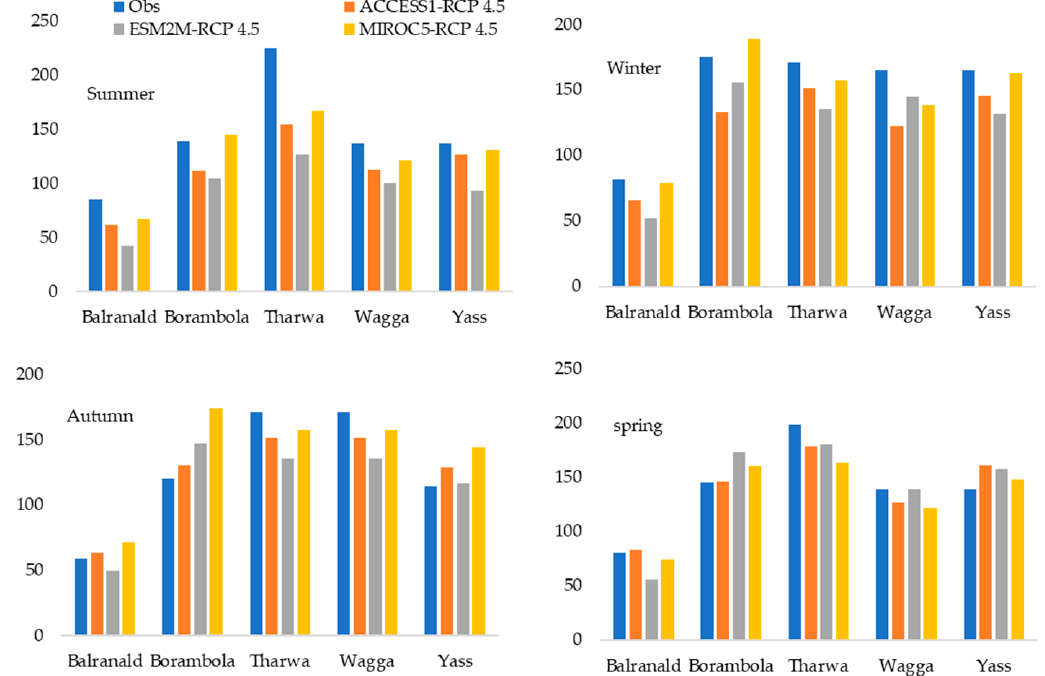
Figure 8. Predicted and observed annual rainfall for sub-catchments in the Murrumbidgee River basin under the RCP 4.5 and RCP 8.5 climate scenarios.